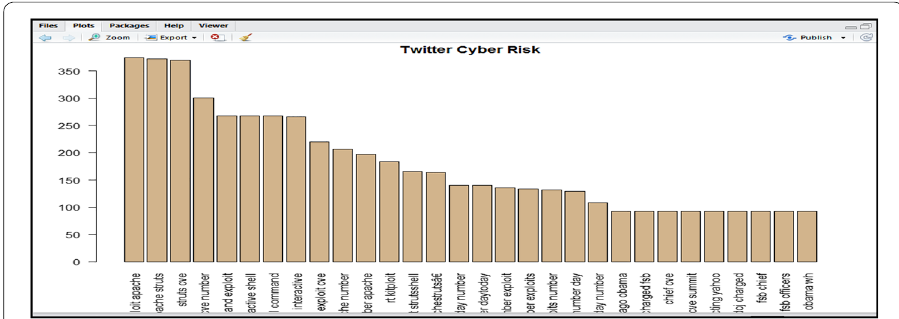
Fig. 5 Twitter N-gram histogram analysis. This is to show that what people speak mostly on Twitter regarding the cyber-attack. It shows cyber-attack occurred mostly through